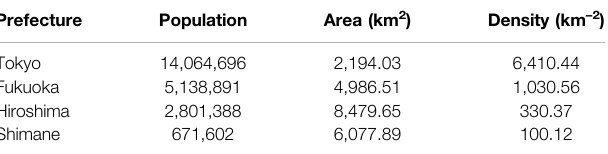
TABLE 2 | Demographic and geographic data of the Metropolis of Tokyo, Fukuoka, Hiroshima, and Shimane Prefectures.